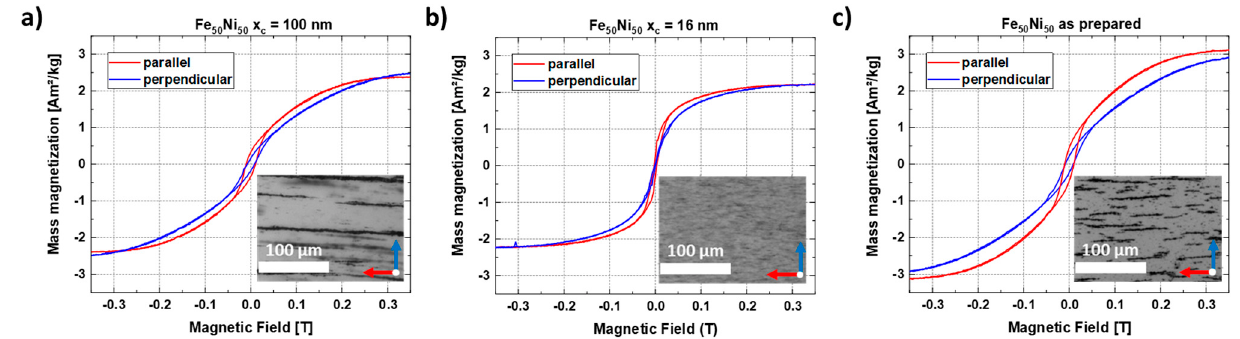
Figure 10. In-plane hysteresis loops measured parallel and perpendicular to the FeNi nanostrands of the 0.2 wt% composite at T = 300 K using colloids with mean sizes of ( a ) x c = 100 nm, ( b ) x c = 16 nm, and the ( c ) as-prepared colloid.